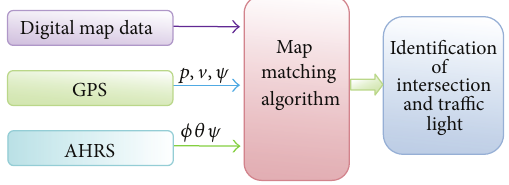
Figure 3: Sensor integration for MM.